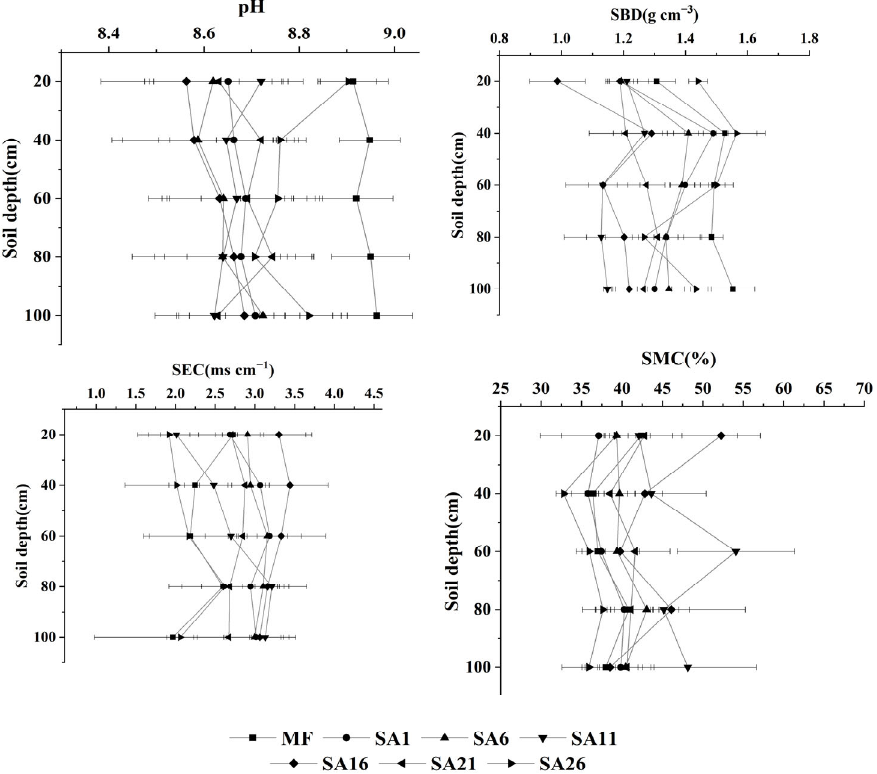
Figure 2. Deep changes in soil properties at different stages of invasion.